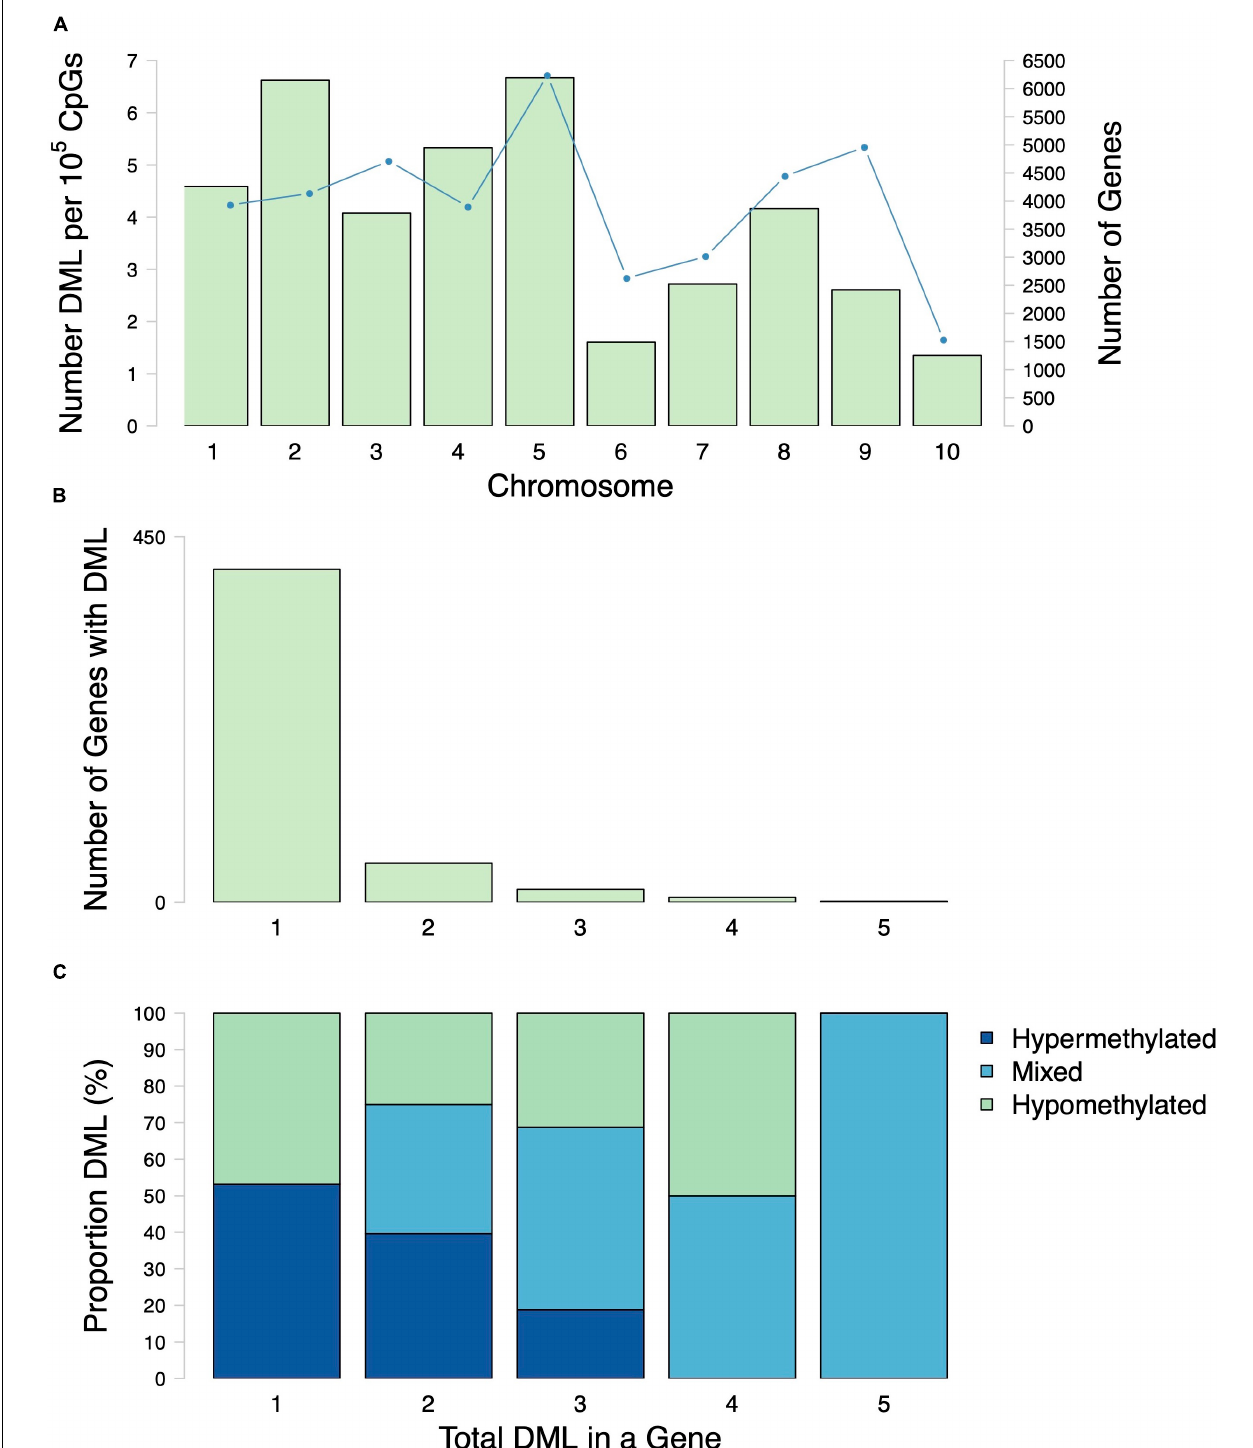
FIGURE 5 | Distribution of DML among chromosomes and genes. (A) Number of DML normalized by number of CpG in each chromosome (bars) and number of genes (line) in each C. virginica chromosome. (B) Number of genes with various numbers of DML per gene (1–5). Most genes that contained DML only had 1 DML. (C) Proportion of hypermethylated, hypomethylated DML in genes with various numbers of DML per gene (1–5). Mixed refers to a classification of a gene that has both hypermethylated and hypomethylated DML.